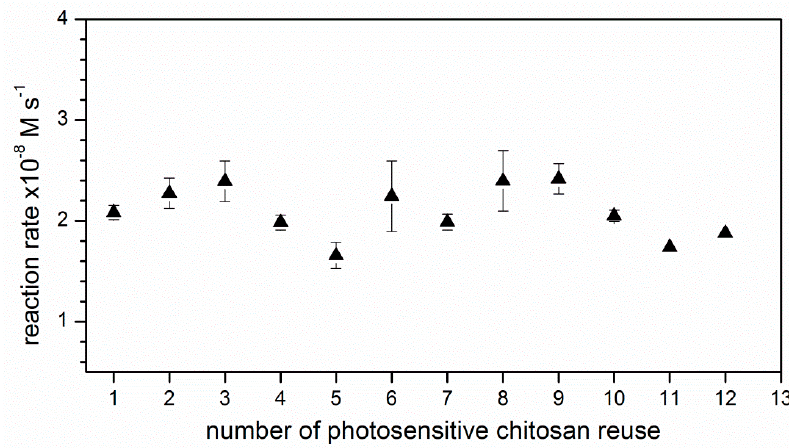
Figure 6. Recyclability of photosensitizing catalysts incorporated into chitosan for the photodegradation of 2,4DCP after 12 cycles.